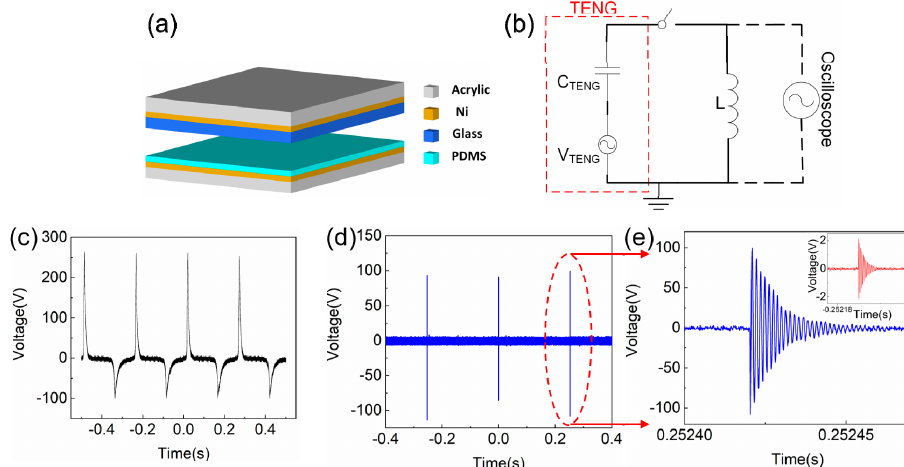
Figure 1. TENG structure ( a ), the equivalent circuit for the sensor system with a microswitch ( b ), open-circuit (~100 M Ω external load) voltage output ( c ), the boosted and stabilized voltage output ( d ), and the zoom-in resonant signal details with and without (inset) the microswitch ( e